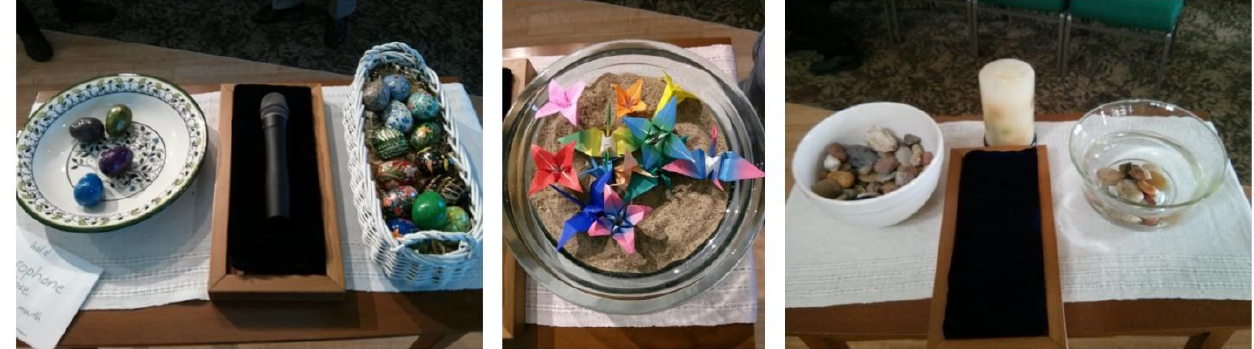
Figure 6. Examples of Objects Used in Sharing.